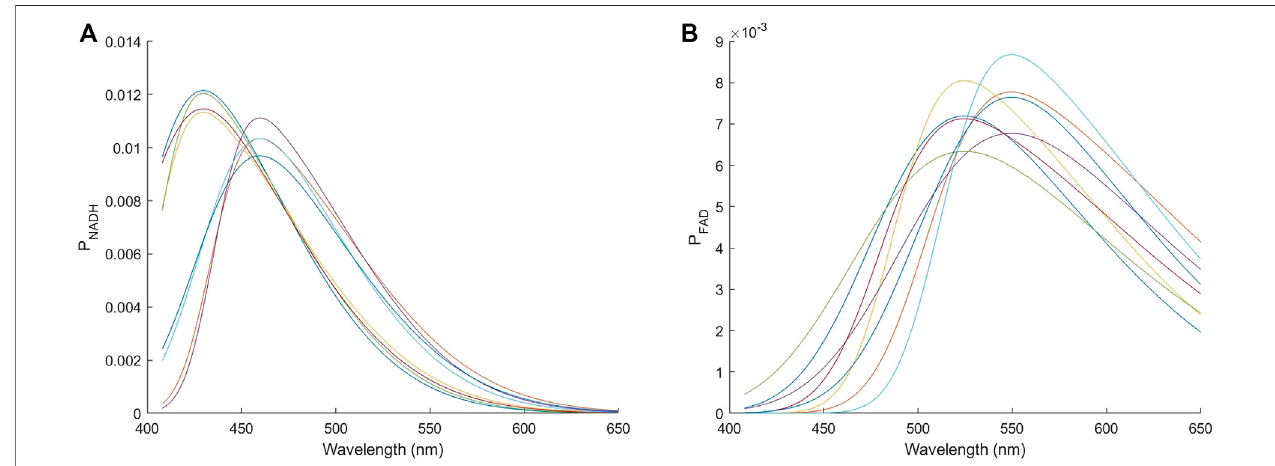
FIGURE 4 | Skew normal distributions used to model the emission spectrum of (A) NADH and (B) FAD. The eight curves in each panel correspond to each of the three parameters ( μ , σ , α ) being set to either the upper or the lower bound.